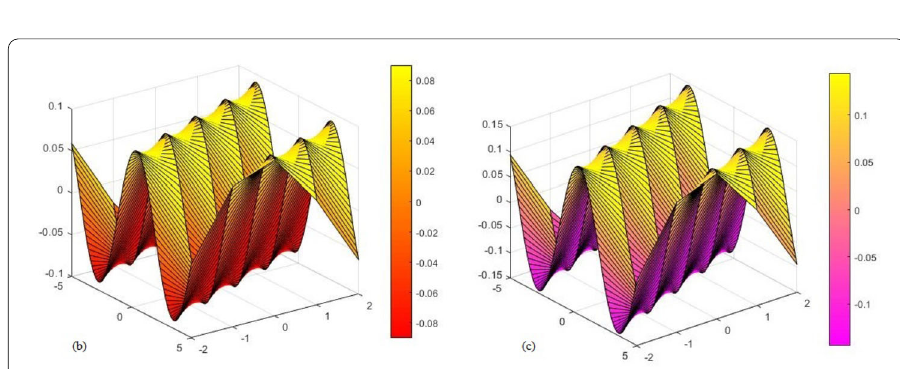
Figure 2 The graph of different approximate solution of (cid:11) ( χ , ϕ , η ) at ϒ = ( c ) 0.8 and ( d ) 0.6 of Example